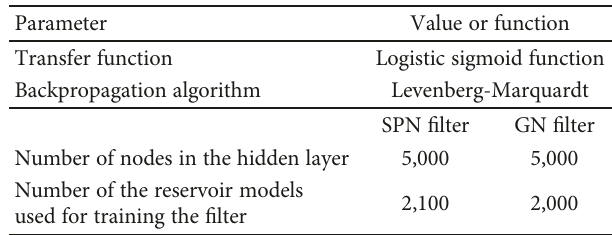
Figure 10: Training images and the reference model used for history matching. P1 to P16 indicate well numbers. Table 3: Experimental settings for reservoir simulation. Table 5: Experimental settings for the SDAE.